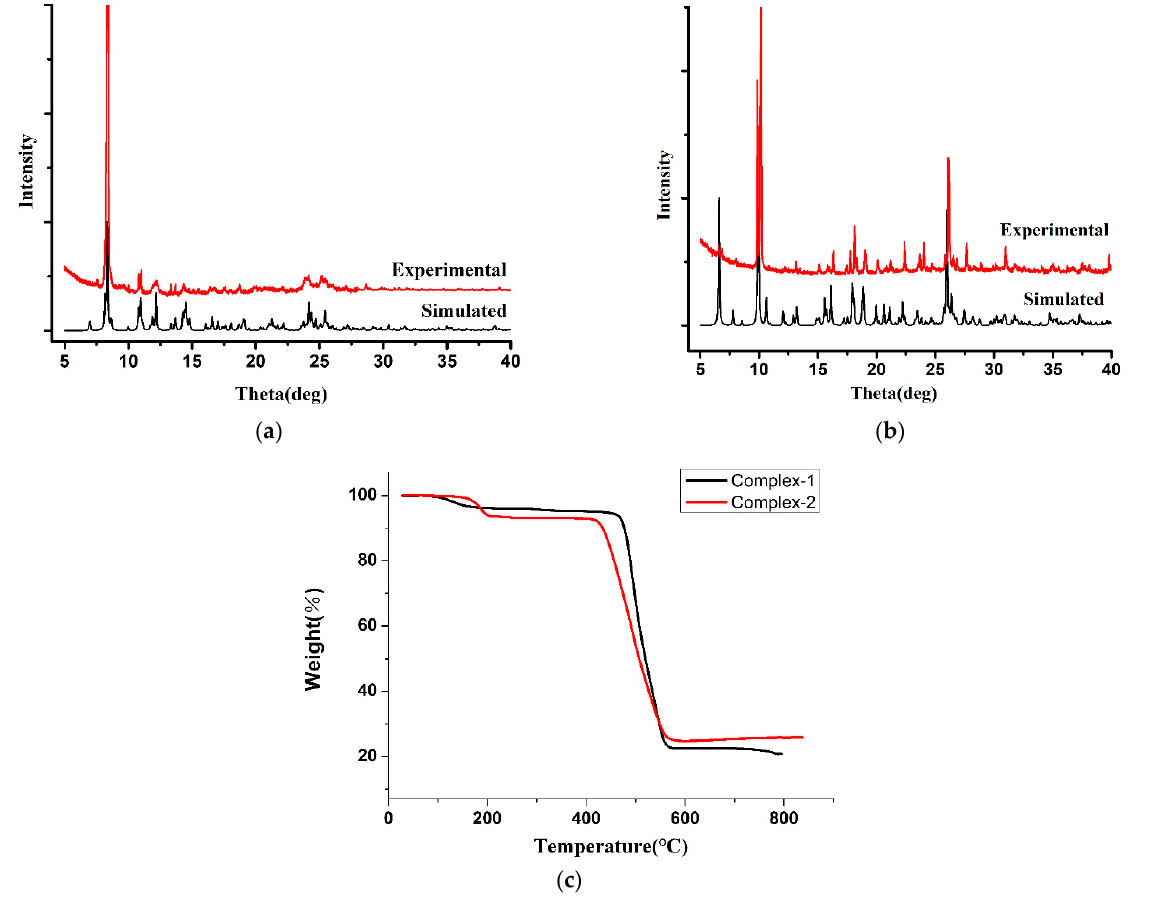
Figure 3. Simulated and experimental PXRD pattern of 1 ( a ) and 2 ( b ). Thermogravimetric (TG) analysis curve of 1 and 2 ( c ).